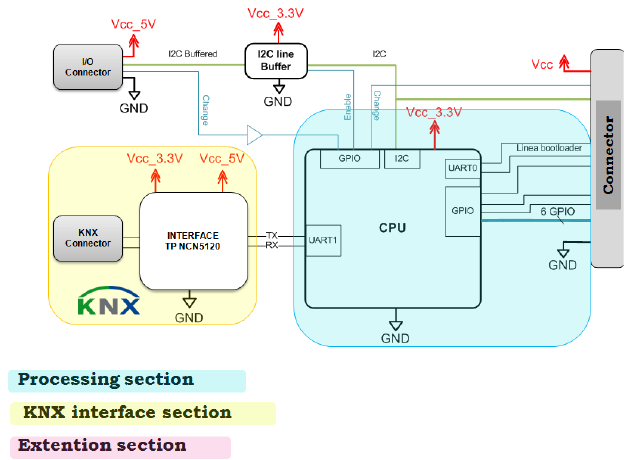
Fig. 10. Block scheme of the designed control board